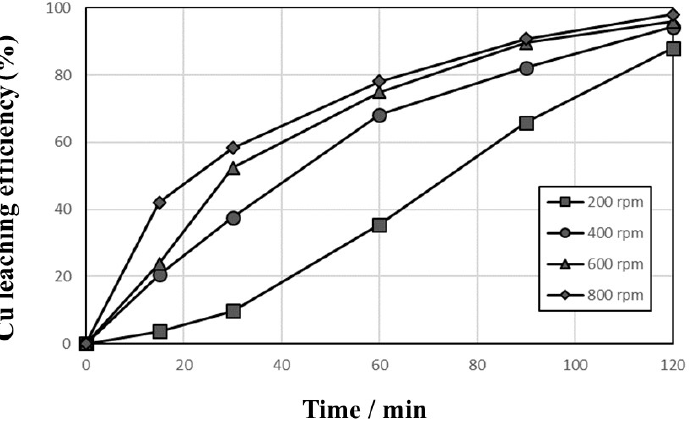
Figure 3. Effects of agitation speed on the leaching behaviors of Cu in 1 mol/L sulfuric acid solu- tion at 90 °C with 10,000 mg/L Cu 2+ , 1% pulp density, and 1000 cc/min O 2 introduction.